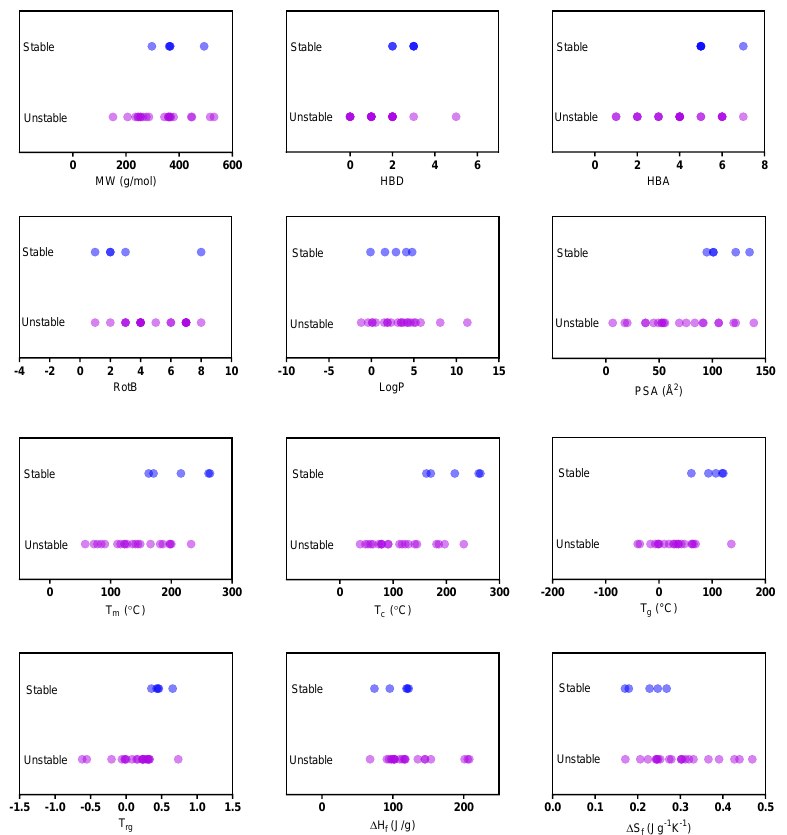
Figure 7. Univariate analysis of the relationships between the long-term physical stability of the spray-dried compounds stored for 168 days (6 months) under dry conditions ( < 5% RH) and selected physicochemical properties. The physicochemical properties presented are molecular weight (MW), number of hydrogen bond donors (HBD), number of hydrogen bond acceptors (HBA), number of rotatable bonds (RotB), logP, polar surface area (PSA), melting point (T m ), crystallization temperature (T c ), glass transition temperature (T g ), reduced glass transition temperature (T rg ), heat of fusion (ΔH f ) and entropy of fusion (ΔS f ). Compounds that remained fully amorphous at the last time point ( t = 168 days) were classified as stable, and compounds that crystallized partly or completely at any time point between 0 and 168 days were considered unstable.